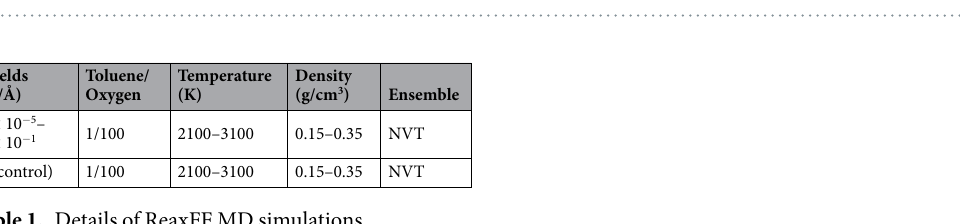
Figure 11. Partial charge of atoms in toluene molecules during ReaxFF NVT-MD simulations. ( a ) simulations with/without Efields at the transition state. ( b ) 1 ps time evolution of partial charge in simulations without Efields before transition state. ( c ) 1 ps time evolution of partial charge in simulations with Efield = 0.2 V/Å before transition state.